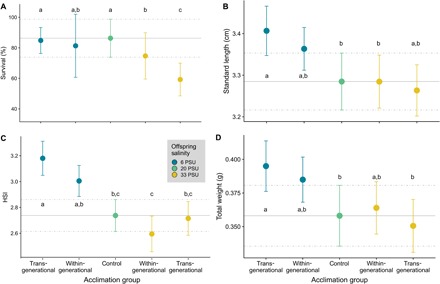
Effects of salinity acclimation on fitness-correlated factors.For all five acclimation groups [control group (20 PSU), within-generational, and transgenerational acclimation to 6 or 33 PSU], survival rates in percent (A), standard length in centimeters (B), hepatosomatic index (C), and total weight in grams (D) are displayed. Letters indicate significant differences resulting from Tukey post hoc tests (table S3). HSI, hepatosomatic index.